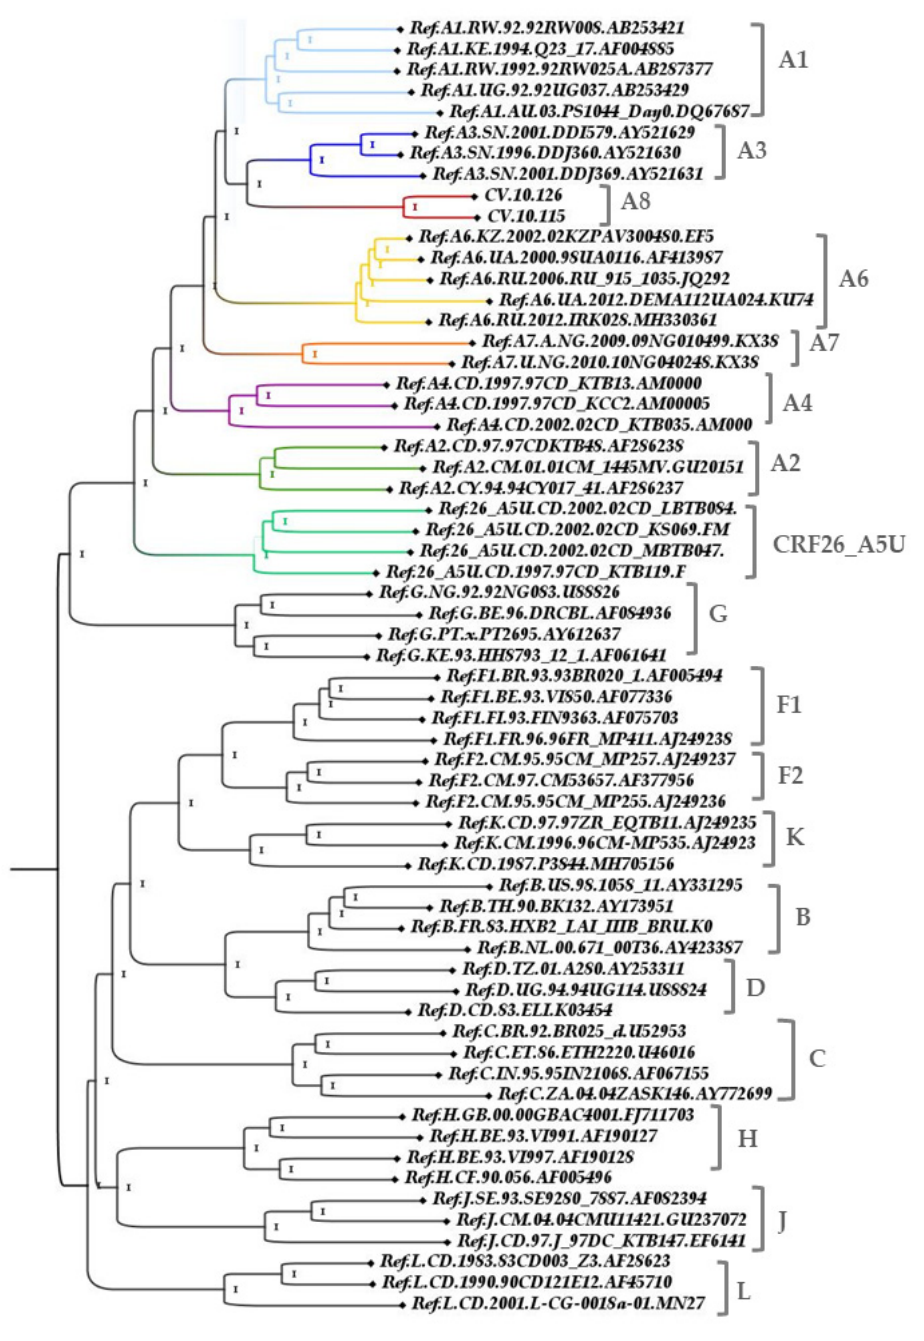
Figure 1. Maximum likelihood (ML) tree implementing nucleotide substitution model General Time Reversible (GTR), indicating the phylogenetic relationships between A sub-subtypes. Approximate likelihood ratio test (ALRT) values are represented only if >0.90. Complete genome analysis (803-9496 relative to the HXB2 reference). The sub-subtype A branches are highlighted.